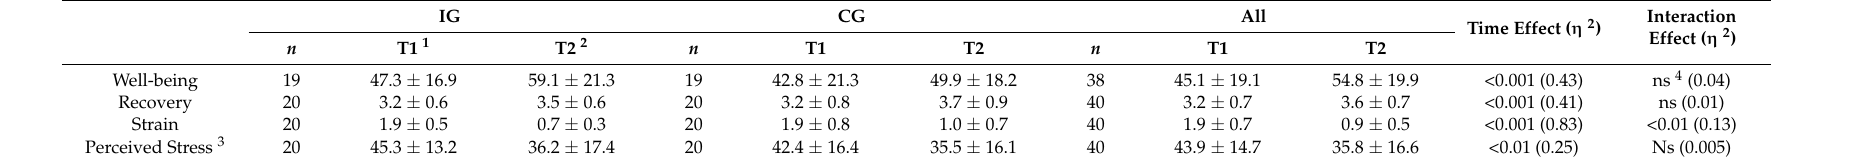
Table 2. Immediate effects of vacation on well-being, recovery, strain, and perceived stress.